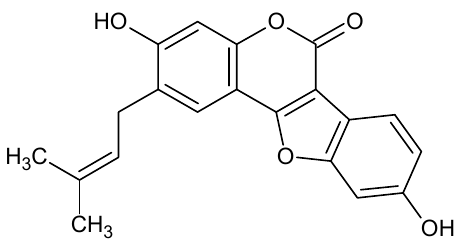
Figure 1. Chemical structure of